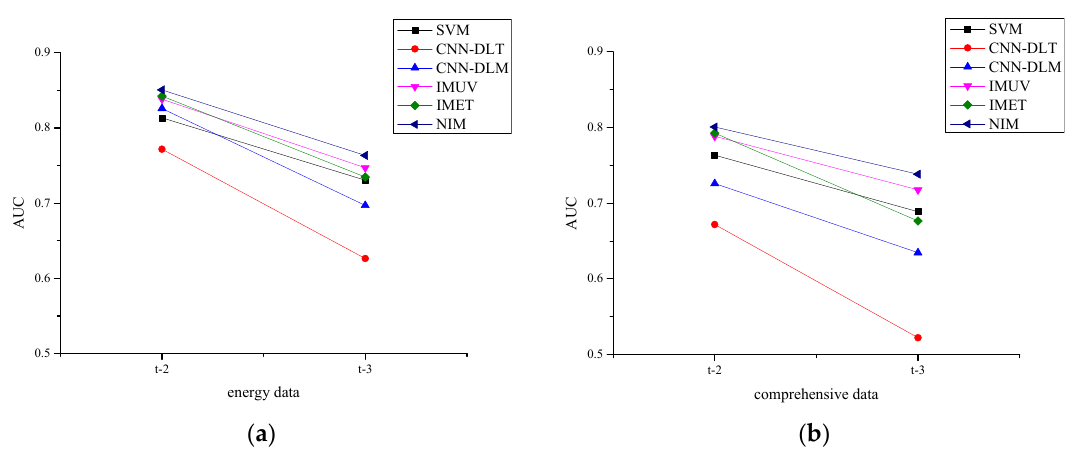
Figure 7. Performance comparisons of models evaluated using the testing data set of the year ( t − 2 ) and ( t − 3 ) . ( a ) Models trained using the energy training data set; ( b ) models trained using the comprehensive training data